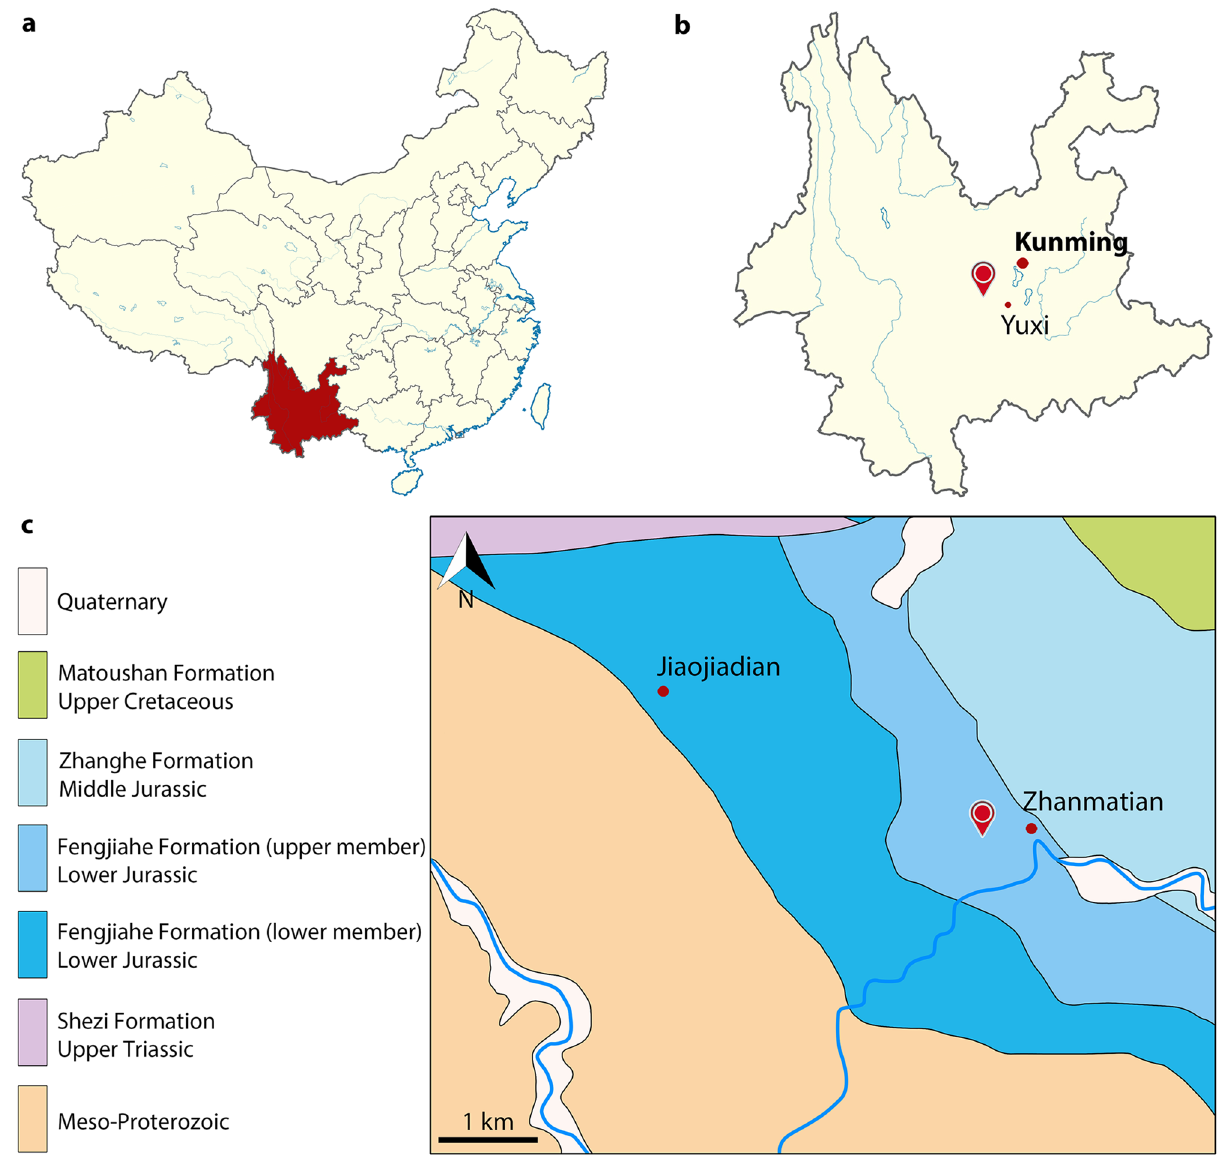
Figure 1. Geographic position and geology of the Irisosaurus yimenensis gen. et sp. nov. locality. ( a ) Map of China, showing the Yunnan Province in red; ( b ) Map of Yunnan Province, showing the location of the Province capital Kunming and Yuxi city relative to the locality position; ( c ) Geological map of the Zhanmatian area, showing the location of the locality in the Lower Jurassic Fengjiahe Formation. Maps drawn with ADOBE Illustrator 22.0 (https ://www.adobe .com/produ cts/illus trato